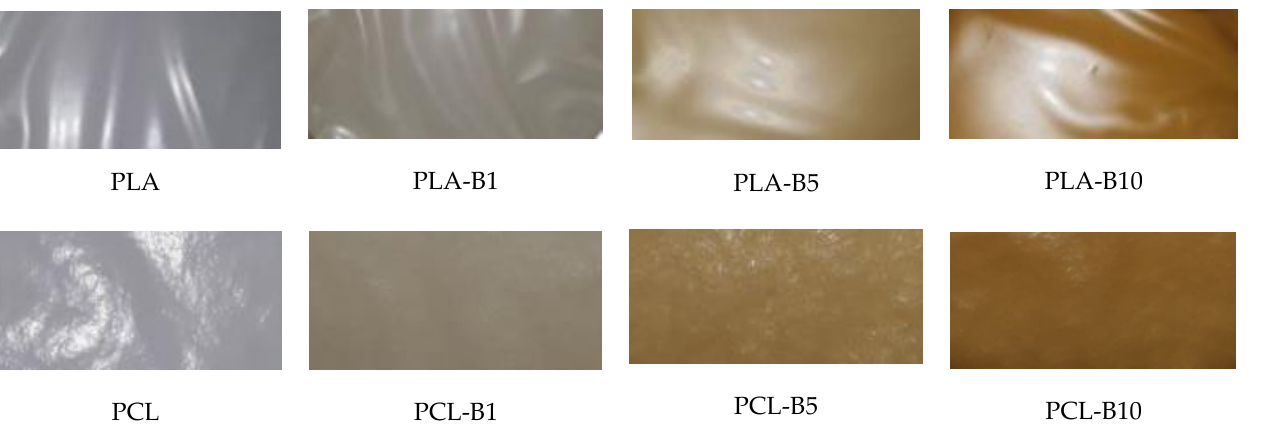
Figure 1. The appearance of the PLA and PCL films without and with birch tar.